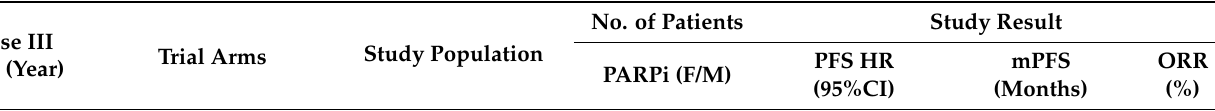
Table 3. Summary of clinical trials involving PARPi and BRCA -positive FBC and MBC